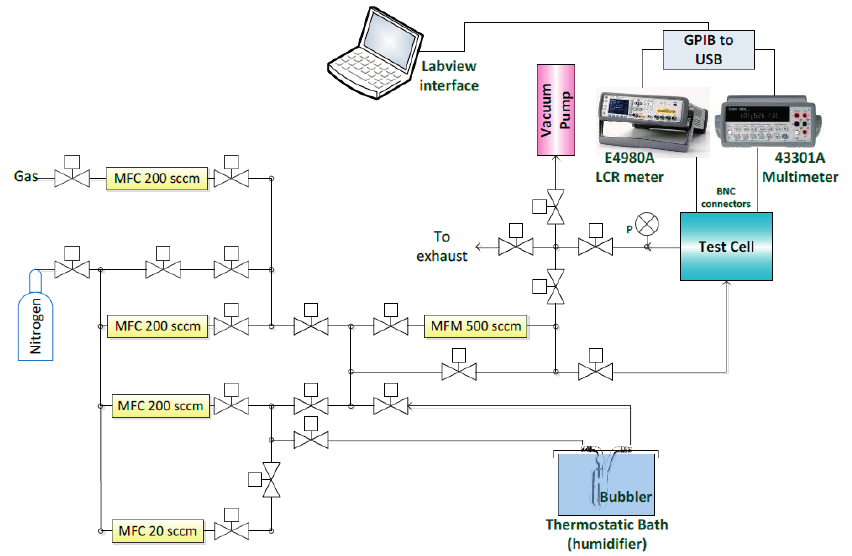
Figure 6. Configuration of the testing